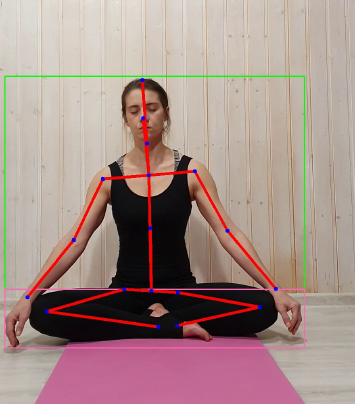
Figure 2. Human body keypoints